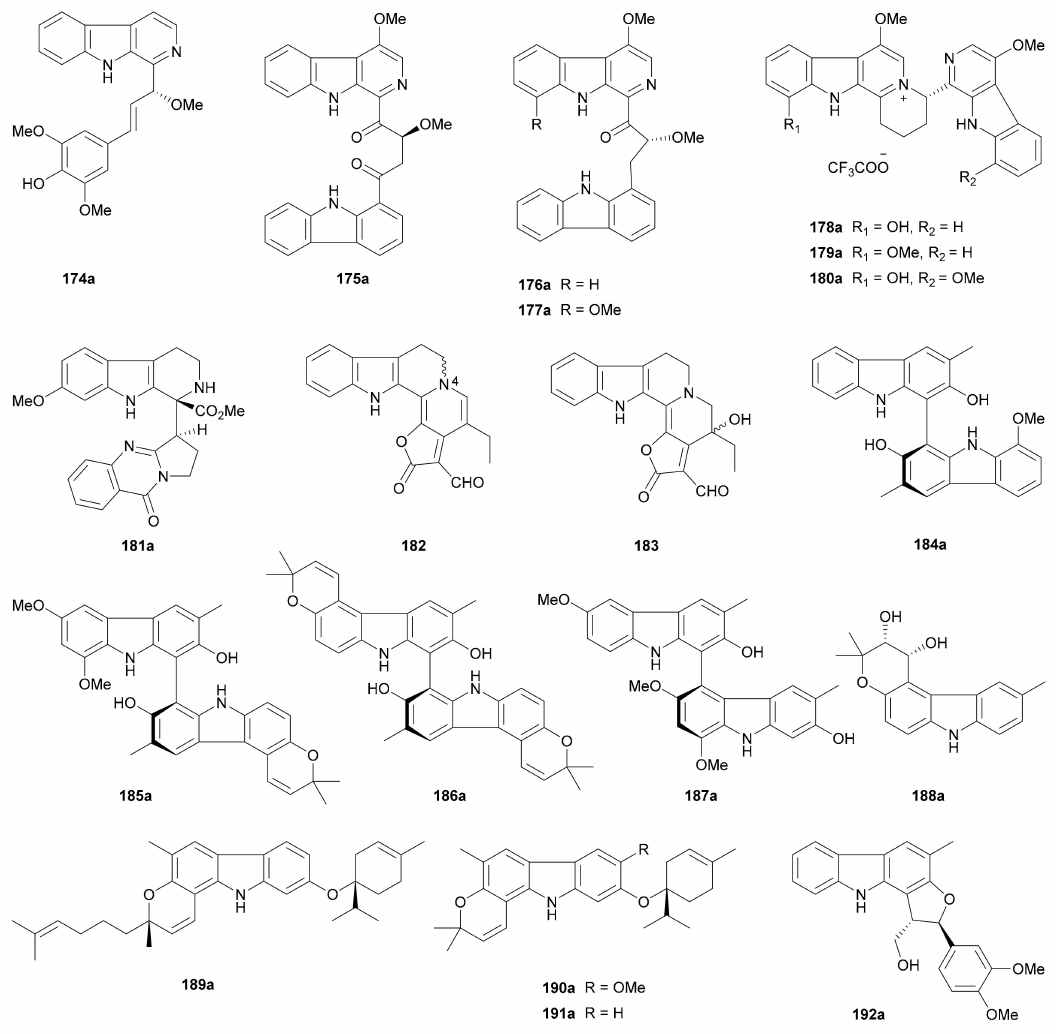
Figure 10. Structures of β -carboline and carbazole